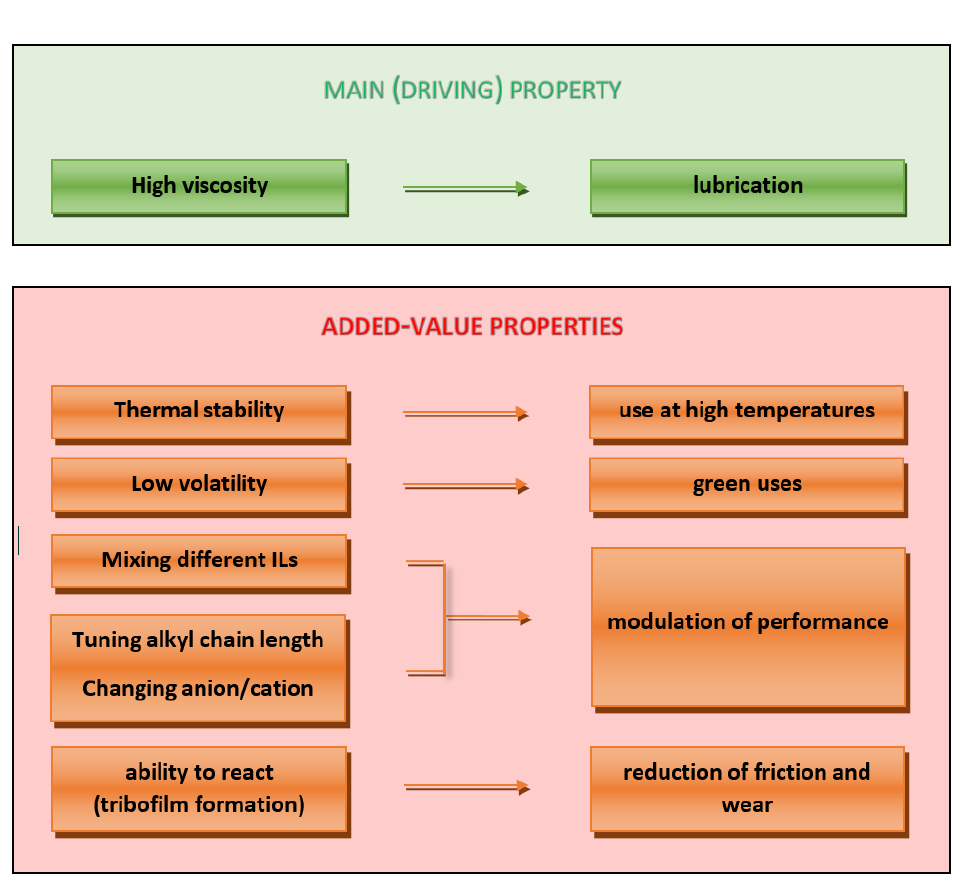
Figure 2. Schematic collection of the IL properties for lubrication purposes.